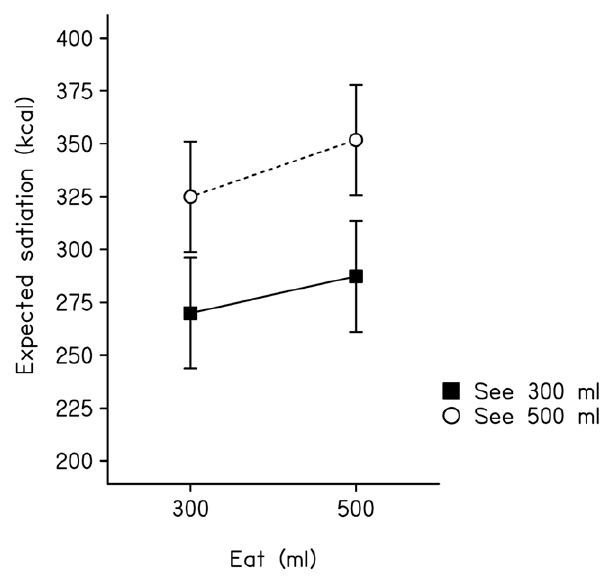
Figure 3. Mean ( + / 2 SEM ) expected satiation scores. Separate values are provided for participants in each condition.